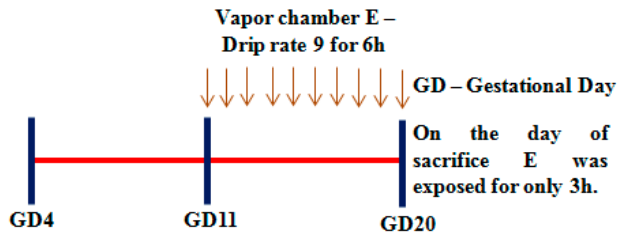
Figure 1. Experimental timeline of intrauterine ethanol exposure using vapor chamber.